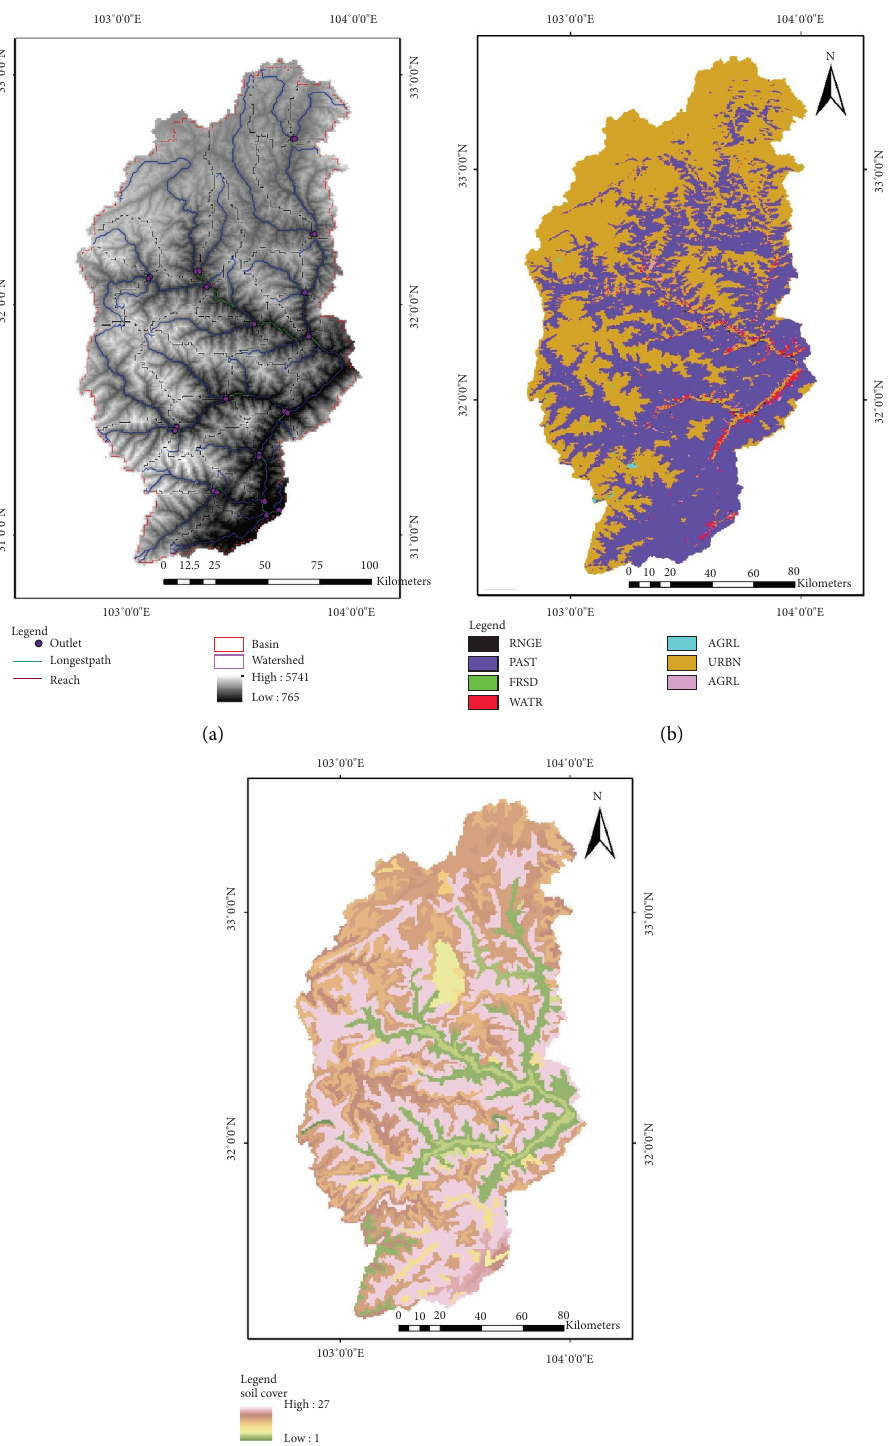
Figure 2: (a) DEM, (b) land use, and (c) soil cover maps of the Minjiang